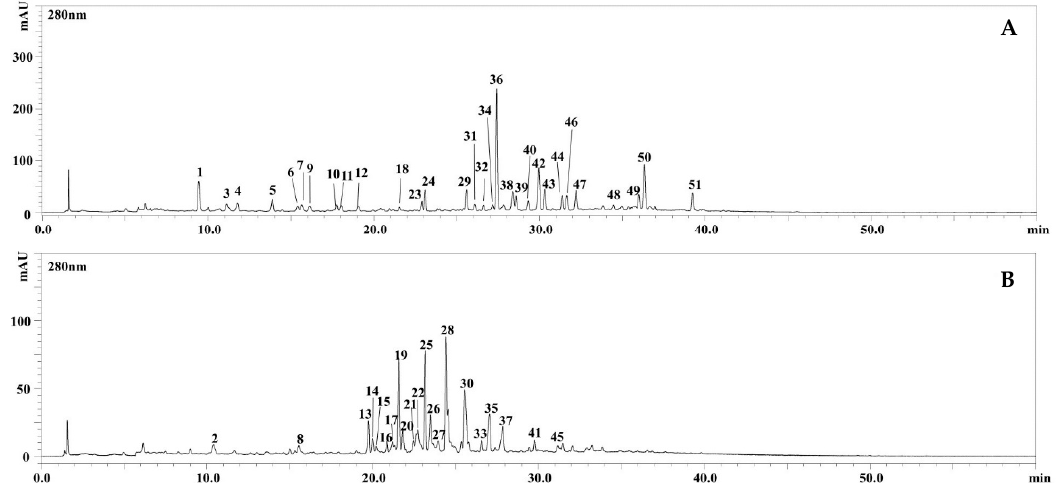
Figure 1. HPLC–PDA chromatograms of the polyphenolic compounds, extracted at 280 nm wavelength, of the hydroalco- holic extracts obtained from the aerial parts of M. fruticulosa subsp. fruticulosa ( A ) and subsp. coronopifolia ( B ). For peak identification, see Table 1.